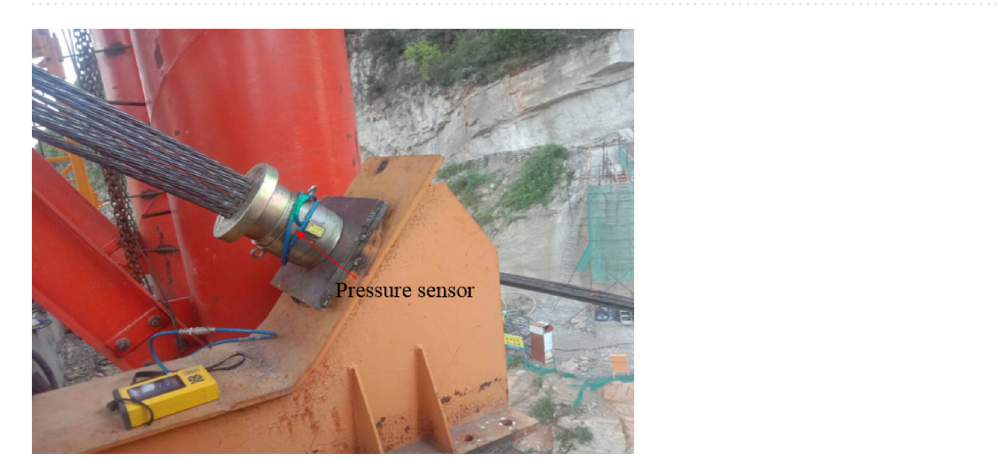
Figure 13. The layout of pressure sensors in Sichuan bank.